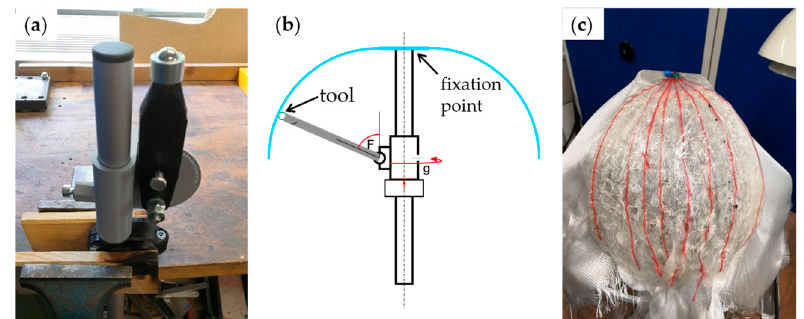
Figure 13. ( a ) Rolling metal ball tool mounted on fixation pole; ( b ) Working principle of the metal ball tool setup; ( c ) Result of thermoset photopolymerization using a metal ball tool [45].